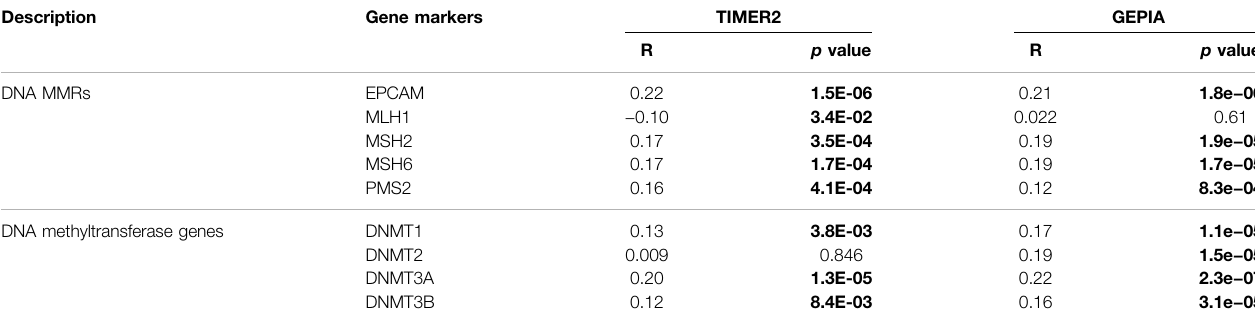
Note: Data in bold indicates p <